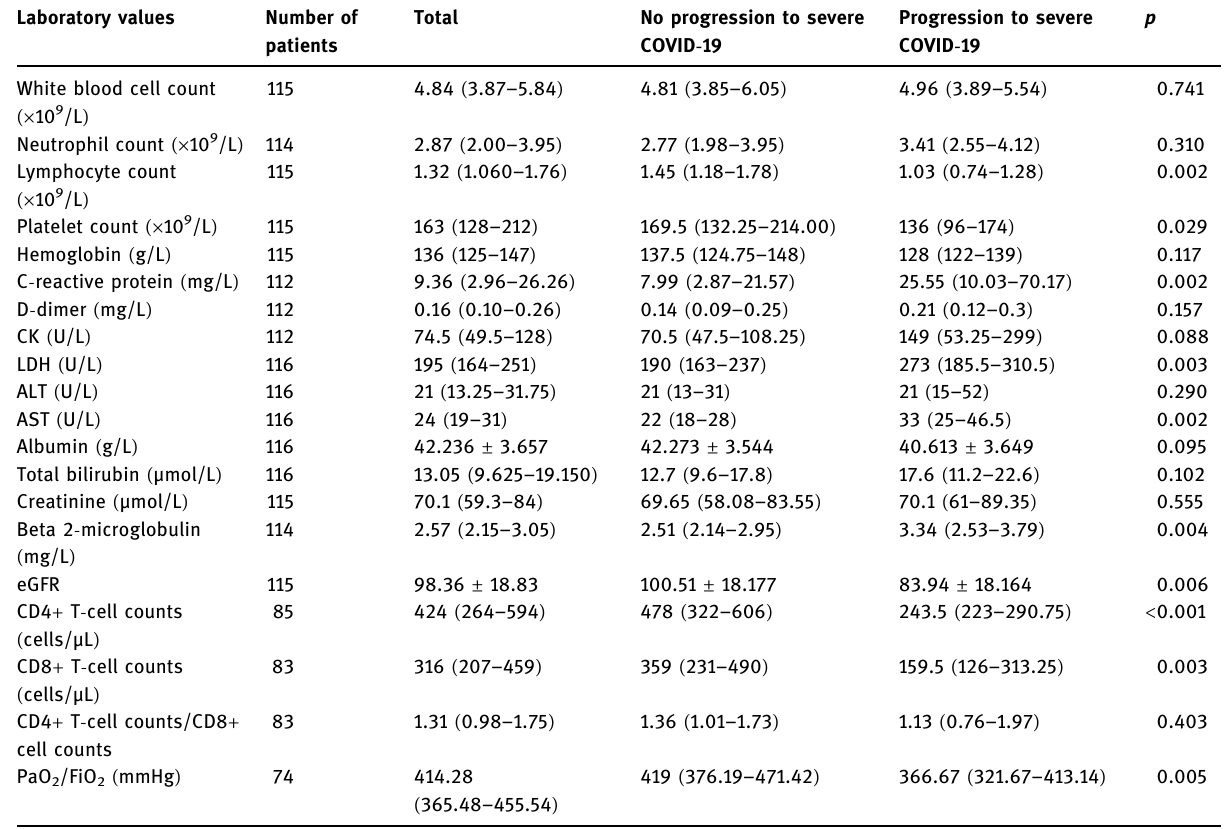
Table 3: Laboratory fi ndings of patients with COVID - 19 at hospital admission